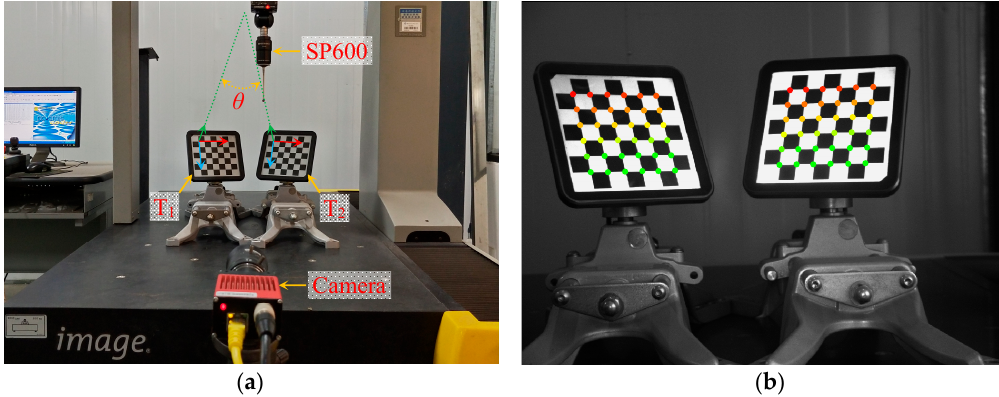
Figure 13. Experiment for measuring attitude. ( a ) Determining θ via CMM and camera. ( b ) One shot in 15 trials with located corners.